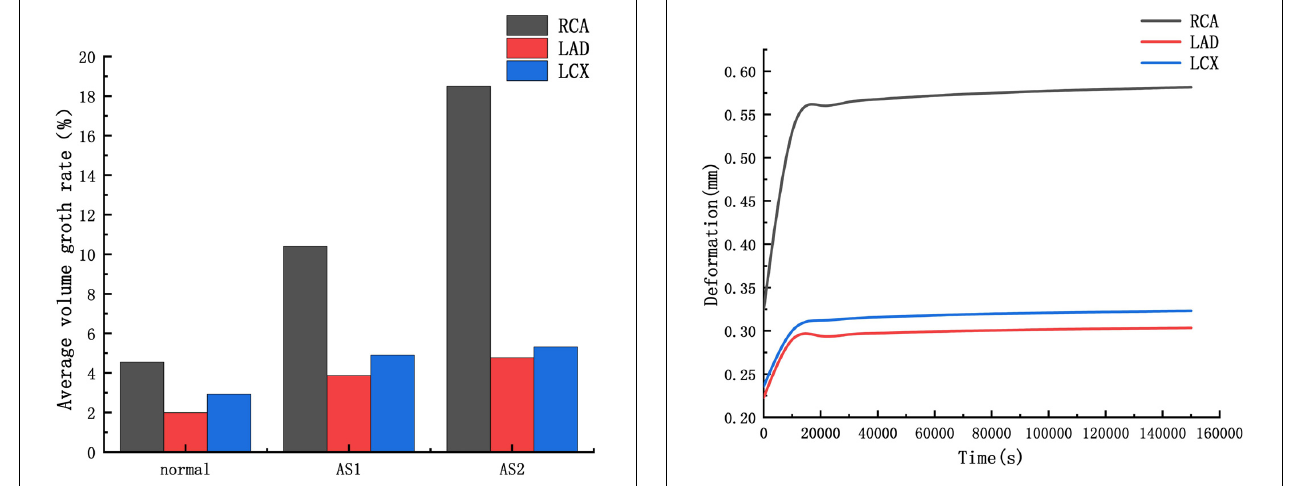
FIGURE 11 | Curve of